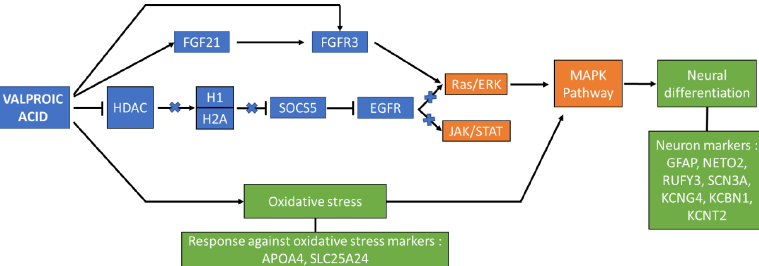
Figure 6. Reductive schematic of the proposed VPA induction pathway in the treatment of ADSCs toward neural di ff Table 3. Proteins involved in the proposed VPA induction pathway of neural differentiation of ADSCs.